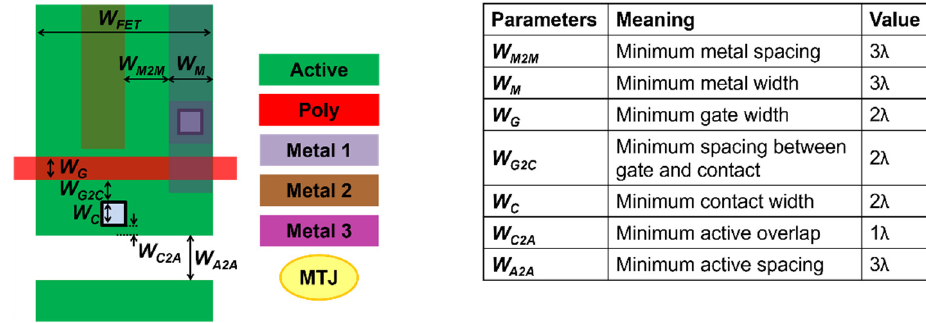
Figure 8. Parameters for the layout design rules.